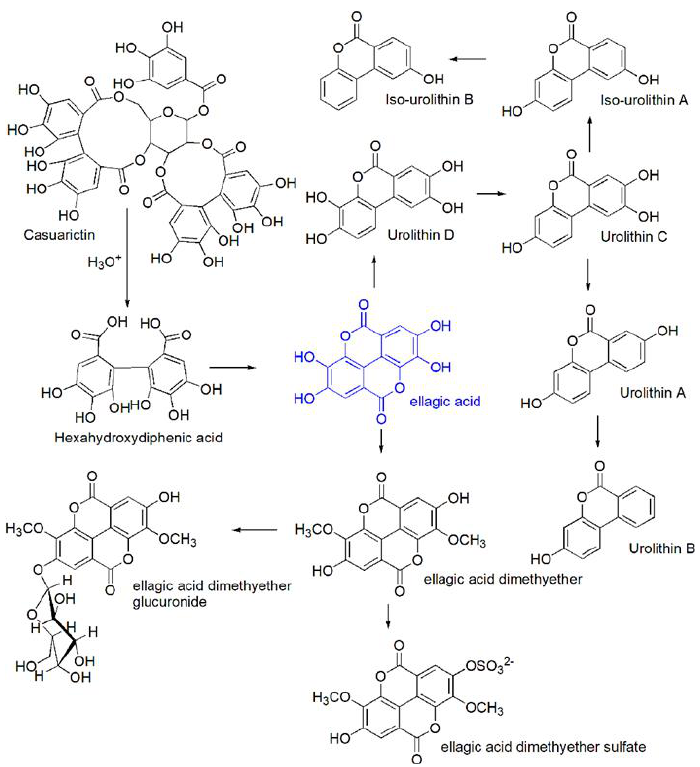
Figure 4. In vivo EA formation and metabolism.